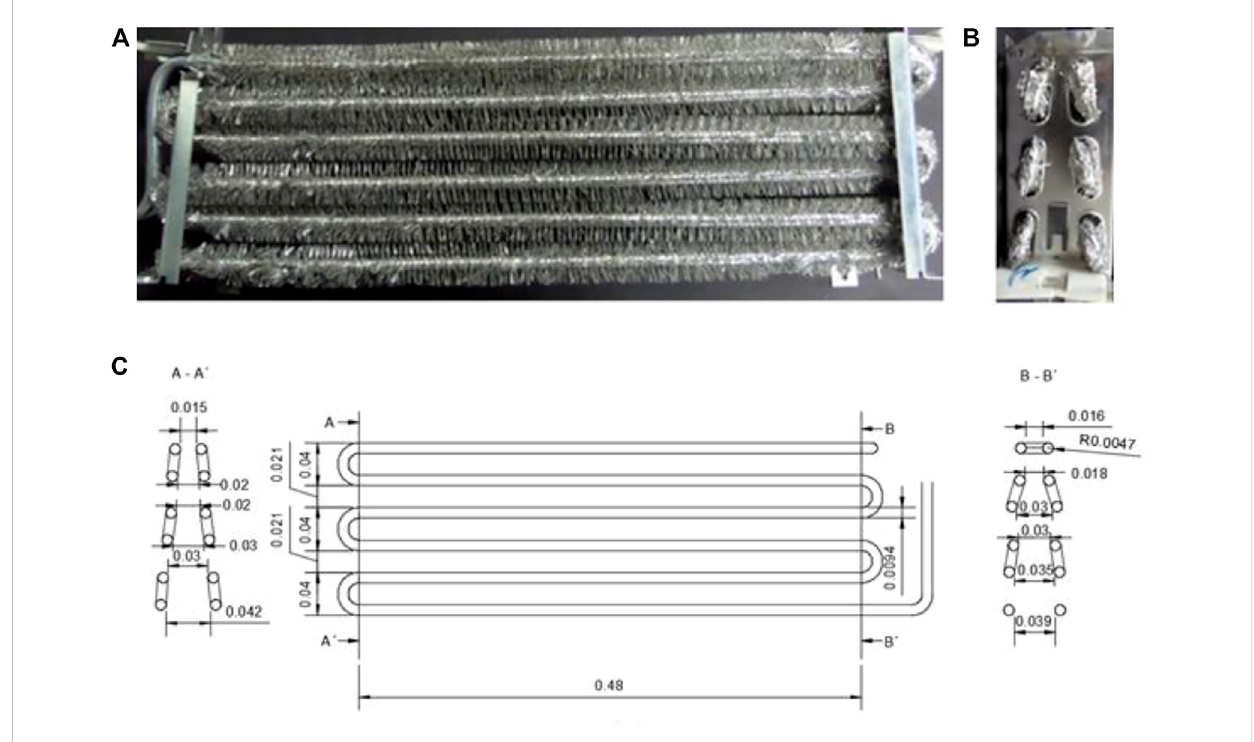
FIGURE 1 Spine- fi nned, inverted-V evaporator (José Pineda et al., 2017). (A) Frontal view (serpentine bundle); (B) side view (inverted-V tube array); (C) evaporator